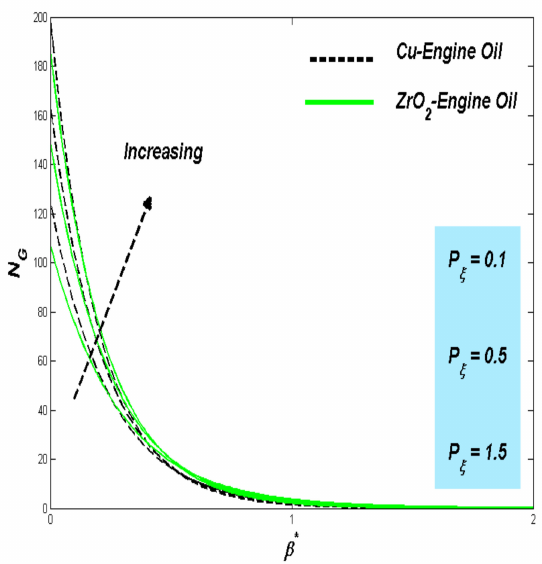
Figure 16. Entropy profile change with P ξ .